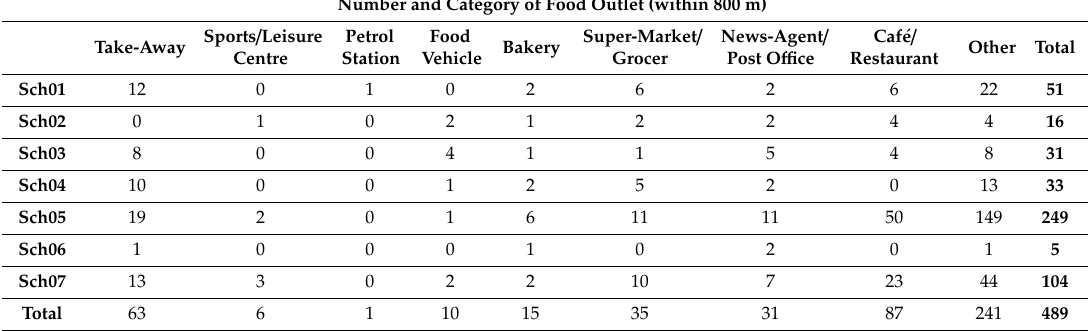
Table 3. Total number of registered and observed food businesses, by outlet type, within 800 m of